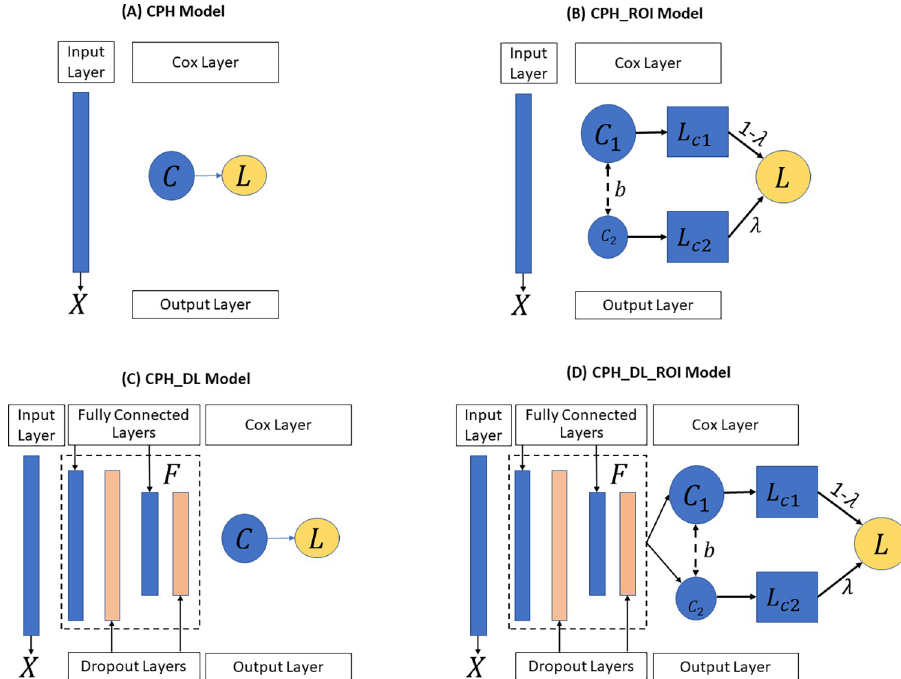
Fig 2. The four TTE prediction models: (A) CPH Model, (B) CPH_ROI Model, (C) CPH_DL Model and (D) CPH_DL_ROI Model. X represents the input features, C is the Cox regression layer, L is the partial hazard loss function, λ is the weight to balance outcomes, and F is the feature extractor to map the input feature into an embedding space. CPH : Cox proportional hazards. ROI : related outcome incorporator. DL : deep learning.